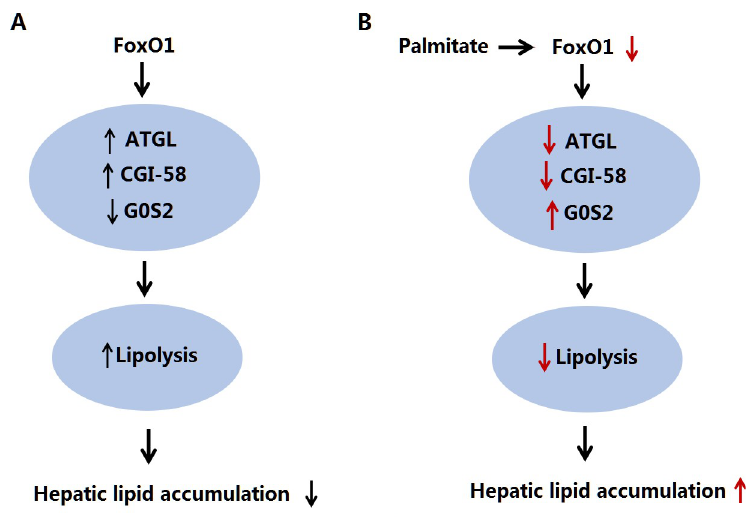
Fig 5. Proposed scheme for the effect and mechanism of FoxO1 in hepatic lipid metabolism. (A) FoxO1 stimulates ATGL and CGI-58 and suppresses G0S2 expression, and subsequently promotes intrahepatic lipolysis in an ATGL- dependent fashion. (B) Inhibition of FoxO1 expression by palmitate contributes to changes in hepatic triglyceride accumulation at least in part due to the inhibition of ATGL-dependent lipolysis.